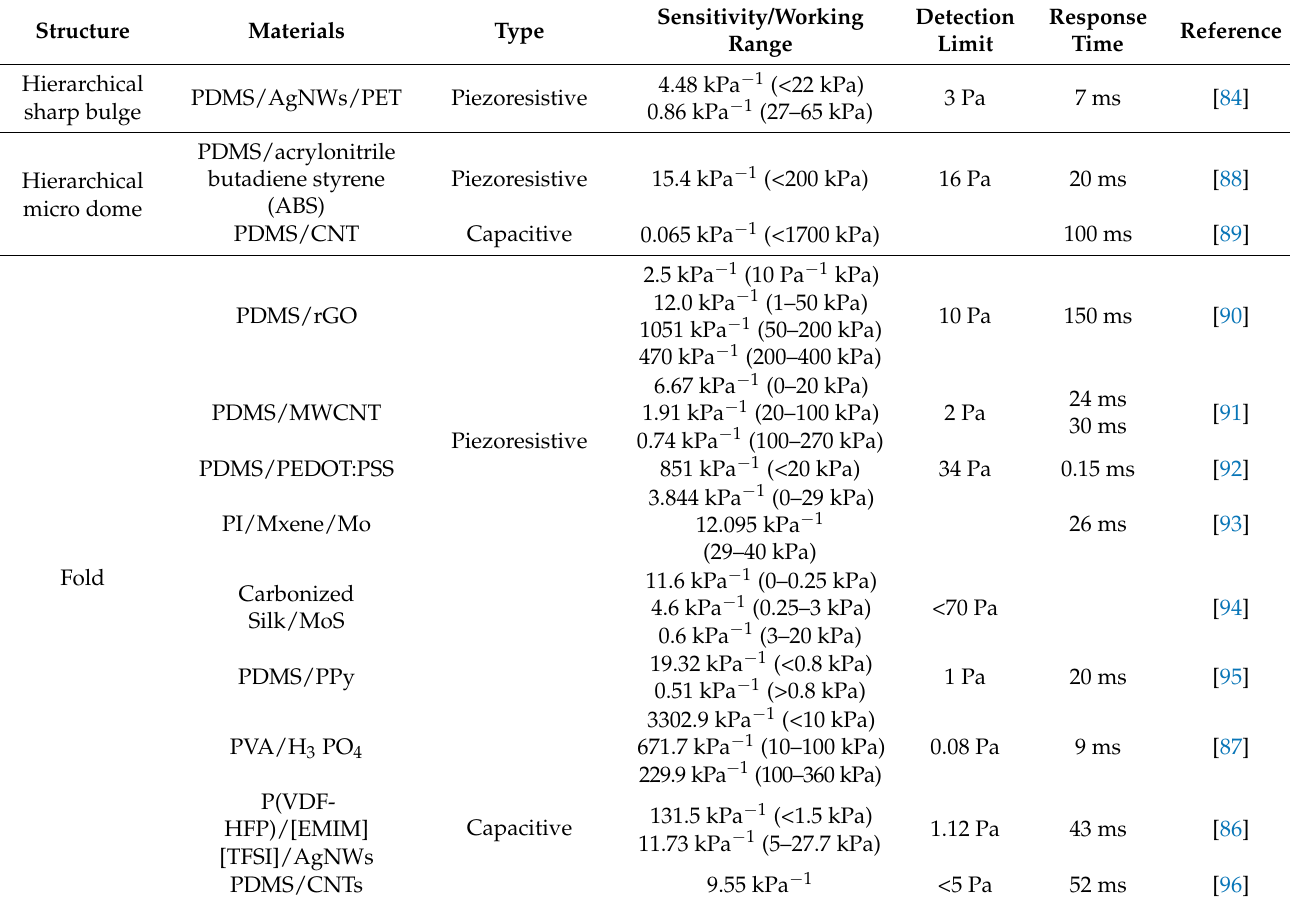
Table 5. The summary of sensor performances with hierarchical